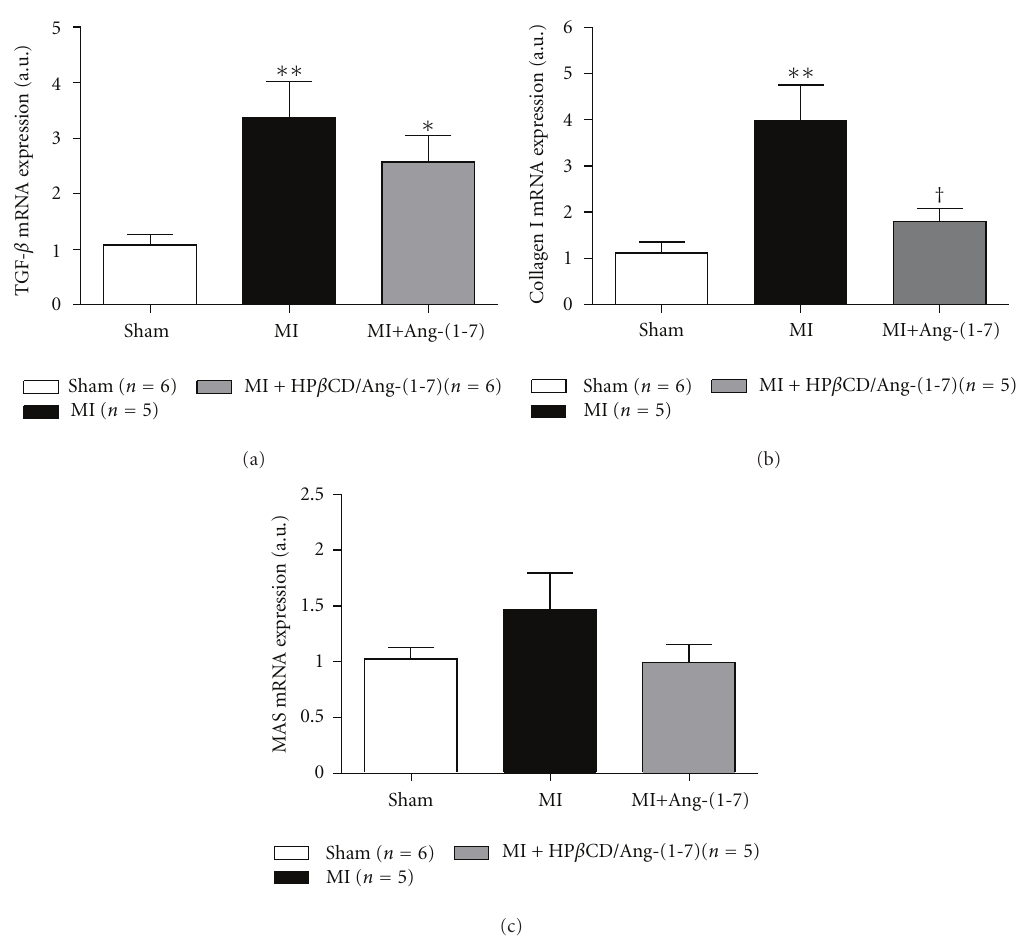
Figure 6: E ff ects of long-term administration of HP β CD/Ang-(1–7) on mRNA expression of (a) TGF- β , (b) collagen type I, and (c) Mas in infarcted animals. ∗ P < 0 . 05 and ∗∗ P < 0 . 01 versus sham; † P < 0 . 01 versus MI (one-way ANOVA followed by the Newman-Keuls posttest) (a.u) = Arbitrary